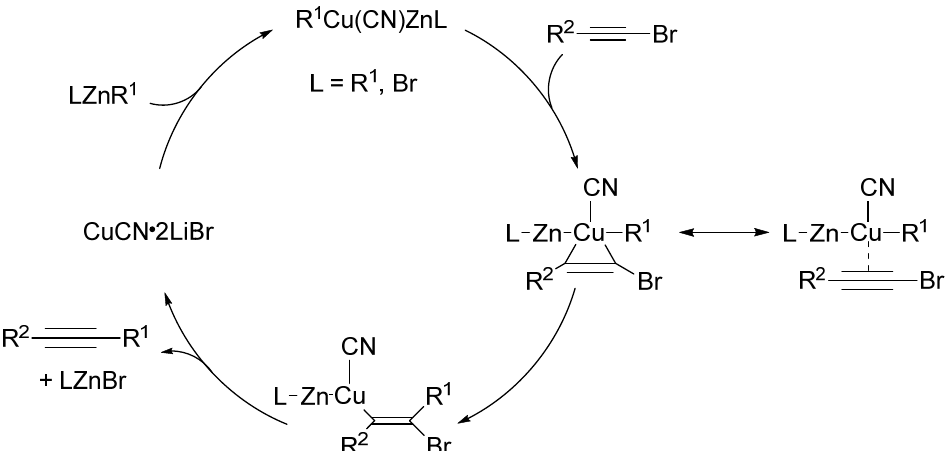
Figure 1. Proposed mechanism for the Cu(I)-catalyzed cross-coupling of 1-bromoalkynes with alkyl zinc reagents [24].